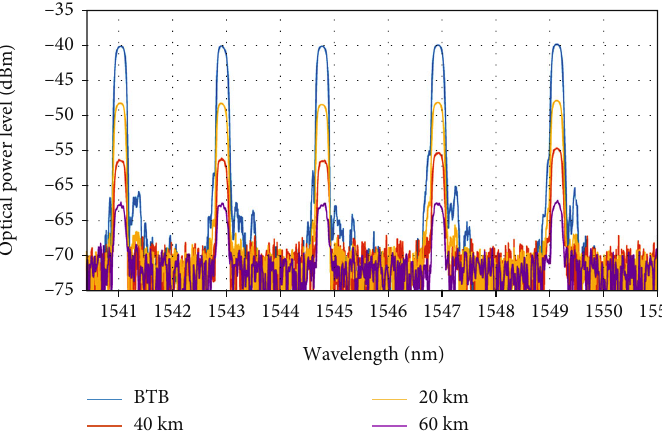
Figure 15: Experimentally measured re fl ected signal spectrum of FBG sensors after BTB, 20, 40 and 60 km transmissions.